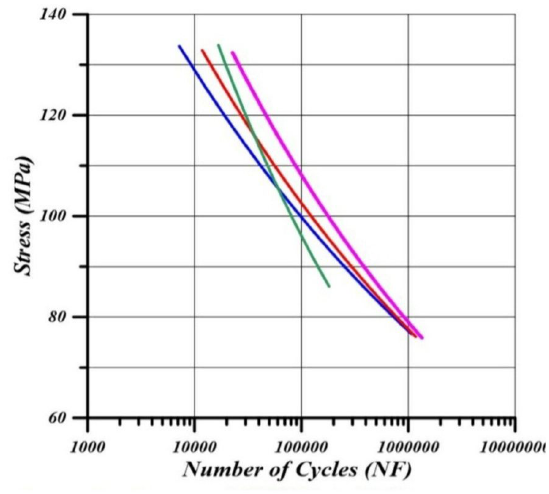
Figure 8: S-N curves for AA7075 with Al 2 O 3 wt% in comparison with the experimental